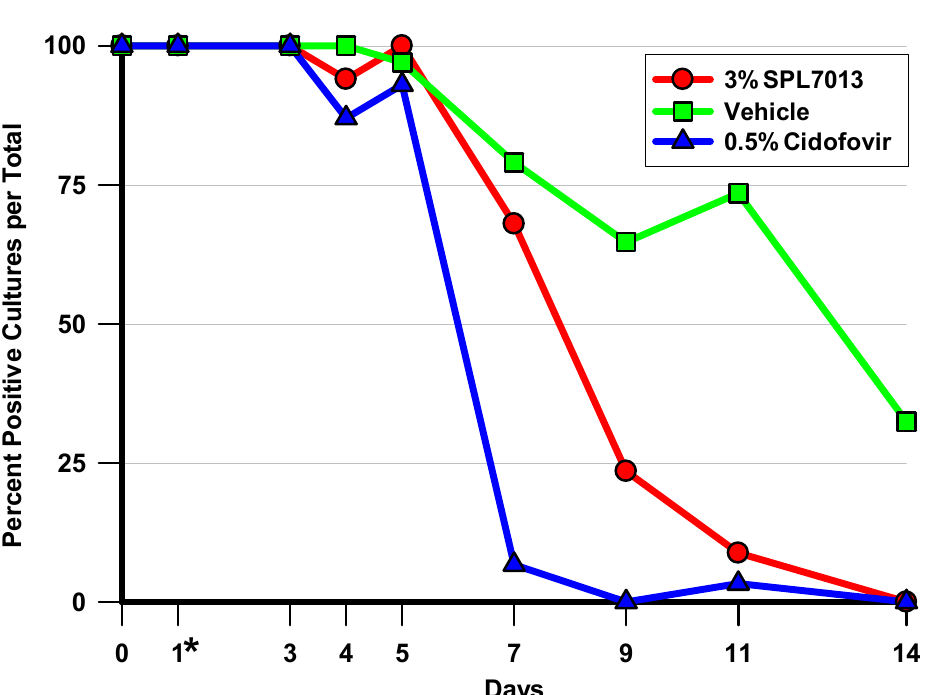
Figure 2. The percentage of HAdV5 positive cultures per total cultures over the course of the antiviral efficacy study. Significant differences were demonstrated on day 7 (0.5% Cidofovir < 3% SPL7013 = Vehicle), day 9 (0.5% Cidofovir < 3% SPL7013 < Vehicle), and days 11 and 14 (0.5% Cidofovir = 3% SPL7013 < Vehicle) ( p ≤ 0.005, chi-square). <, significantly less than; =, statistically indistinguishable; *, indicates that treatment was initiated on day 1.